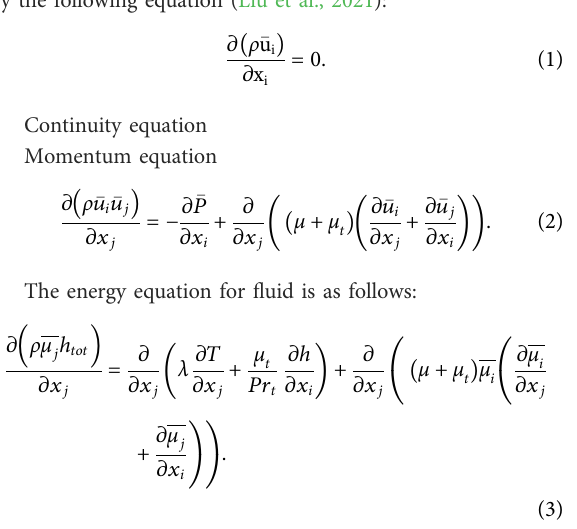
TABLE 3 Geometric parameters of the blade tip of the cooling fi lm hole groove. Blade pro fi le parameter Numerical